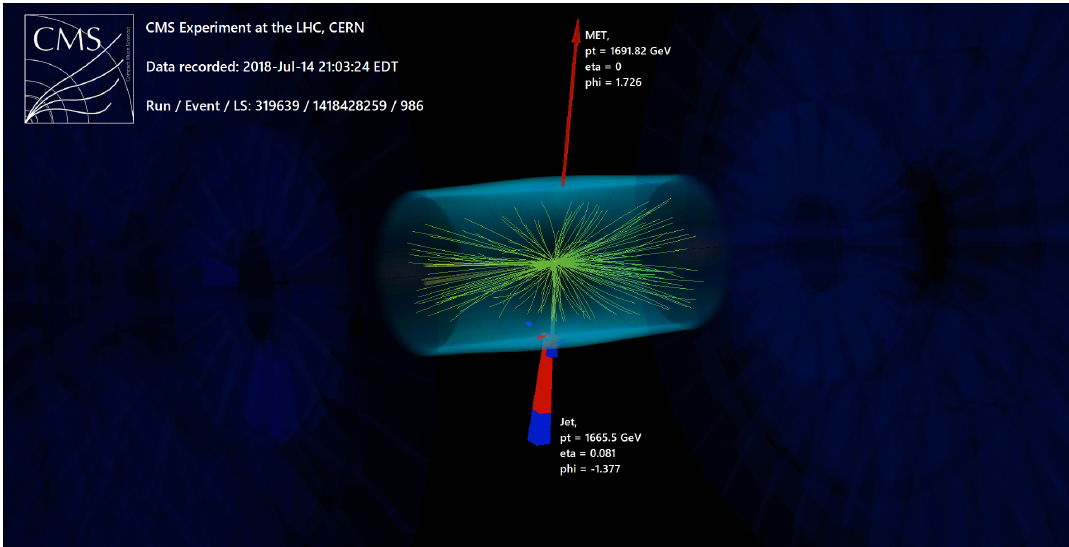
event from the monojet category in the 2018 T jet (calorimeter deposits indicated by the red and blue T (indicated by the red T